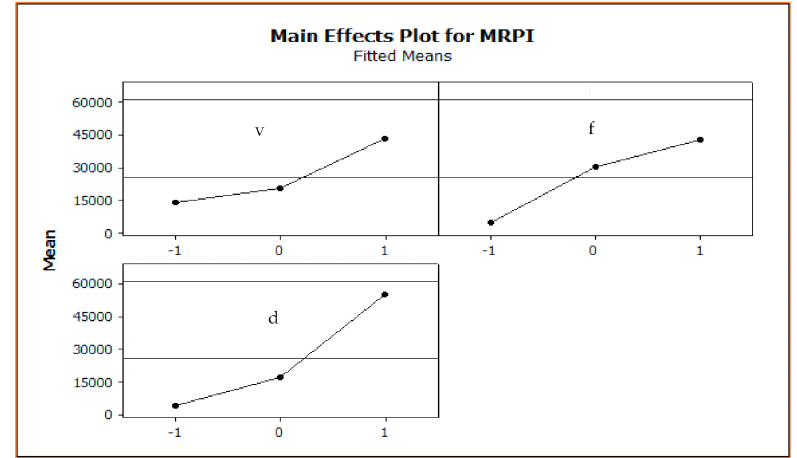
Figure 12. Main effect plot for